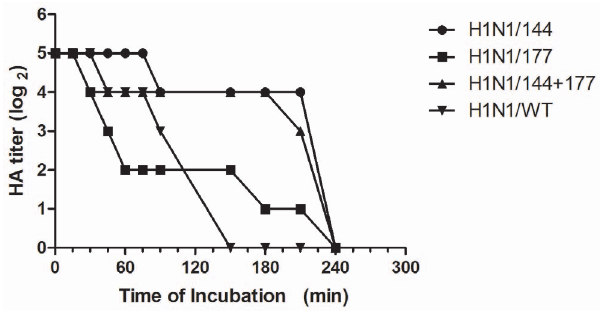
Figure 3. Characterization of viral growth in embryonated SPF chicken eggs. The eggs were infected with each of the viruses and were maintained at 37 u C. The viral titers in the allantoic fluid of infected eggs were examined at 24, 48, 72, 96 h after infection by EID 50 . Titers were expressed as log 10 EID 50 .